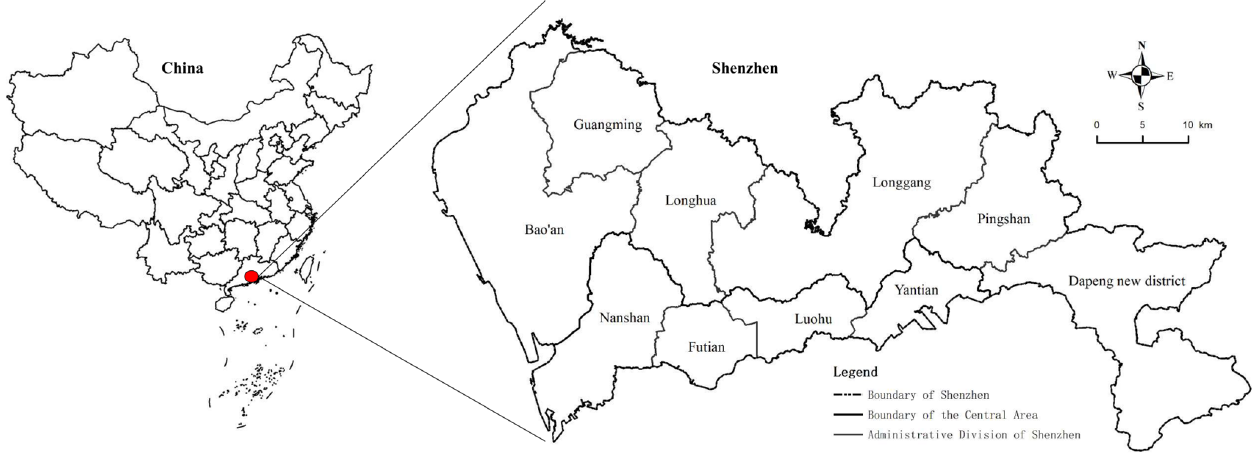
Figure 1. Location of Shenzhen in China.